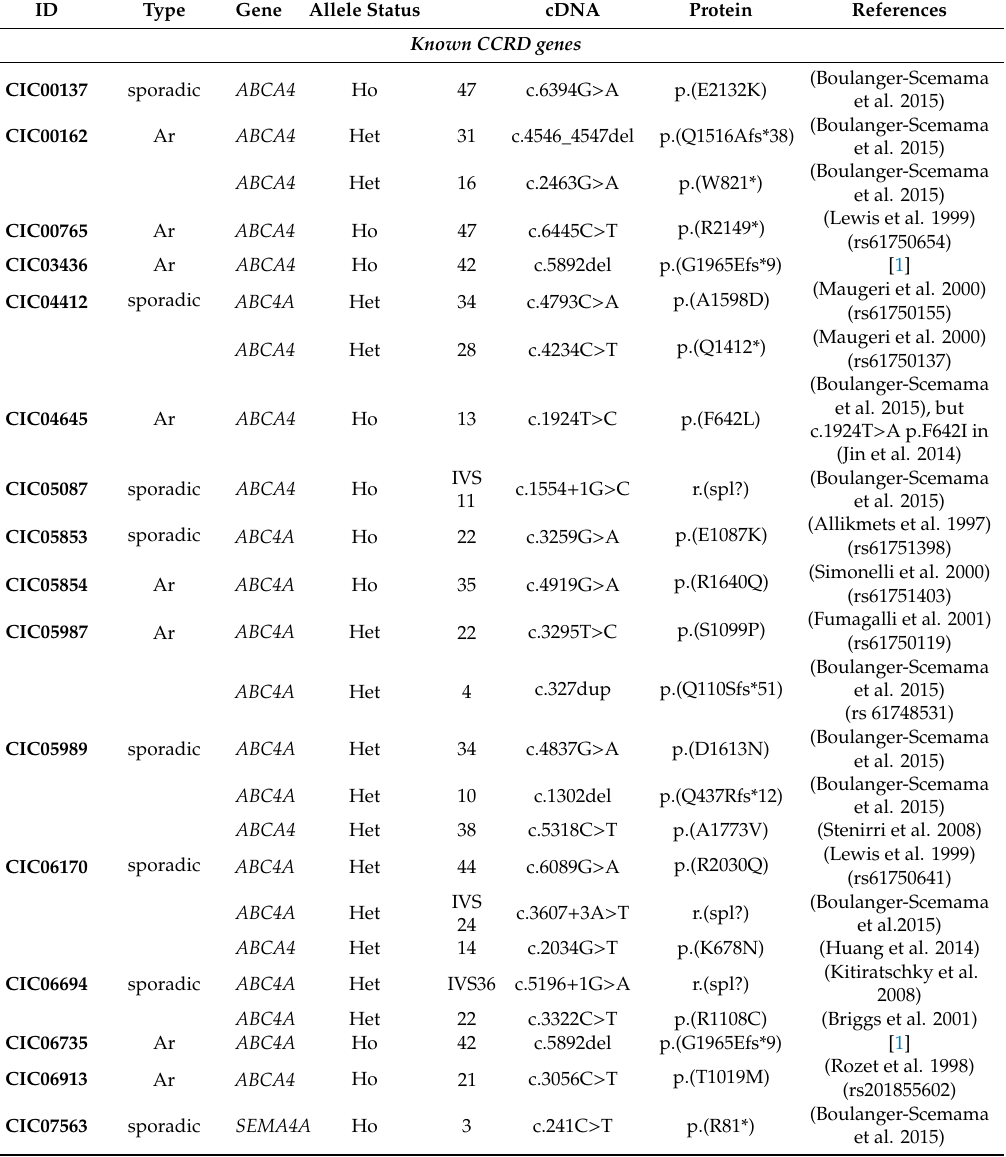
Table 2. Summary of 58 patients carrying pathogenic and likely pathogenic mutations in known CCRD genes or other retinal disease